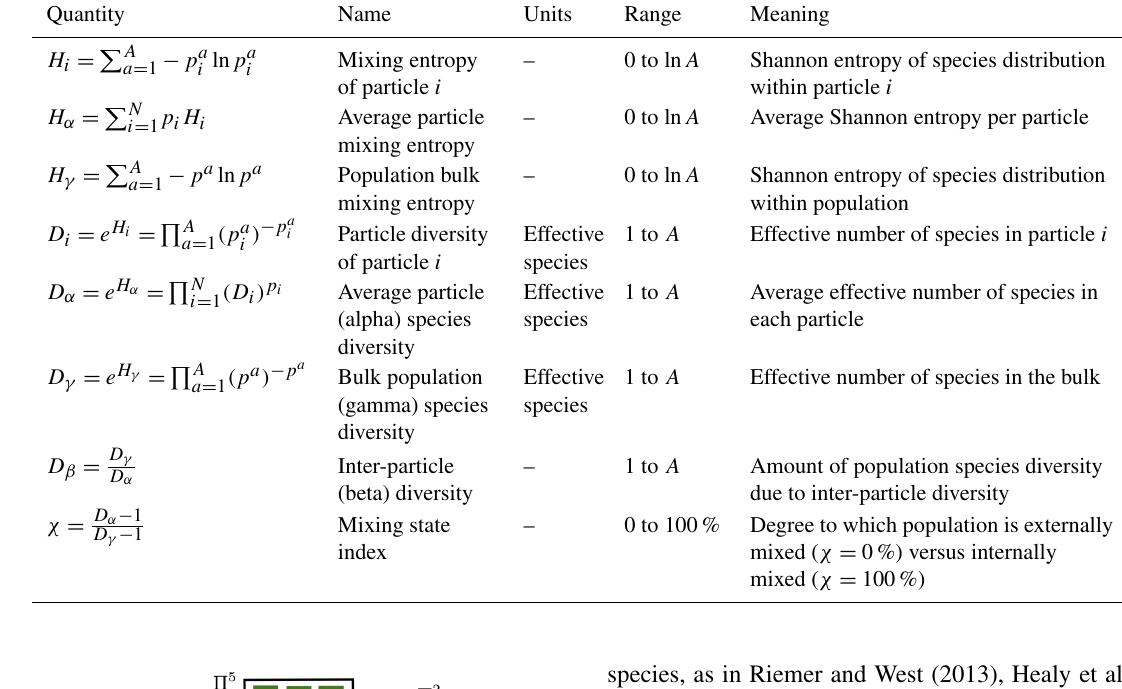
Table 2. Definitions of aerosol mixing entropies, particle diversities, and mixing state index. In these definitions we take 0ln0 = 0 and 0 0 = 1. This table is taken from Riemer and West (2013).